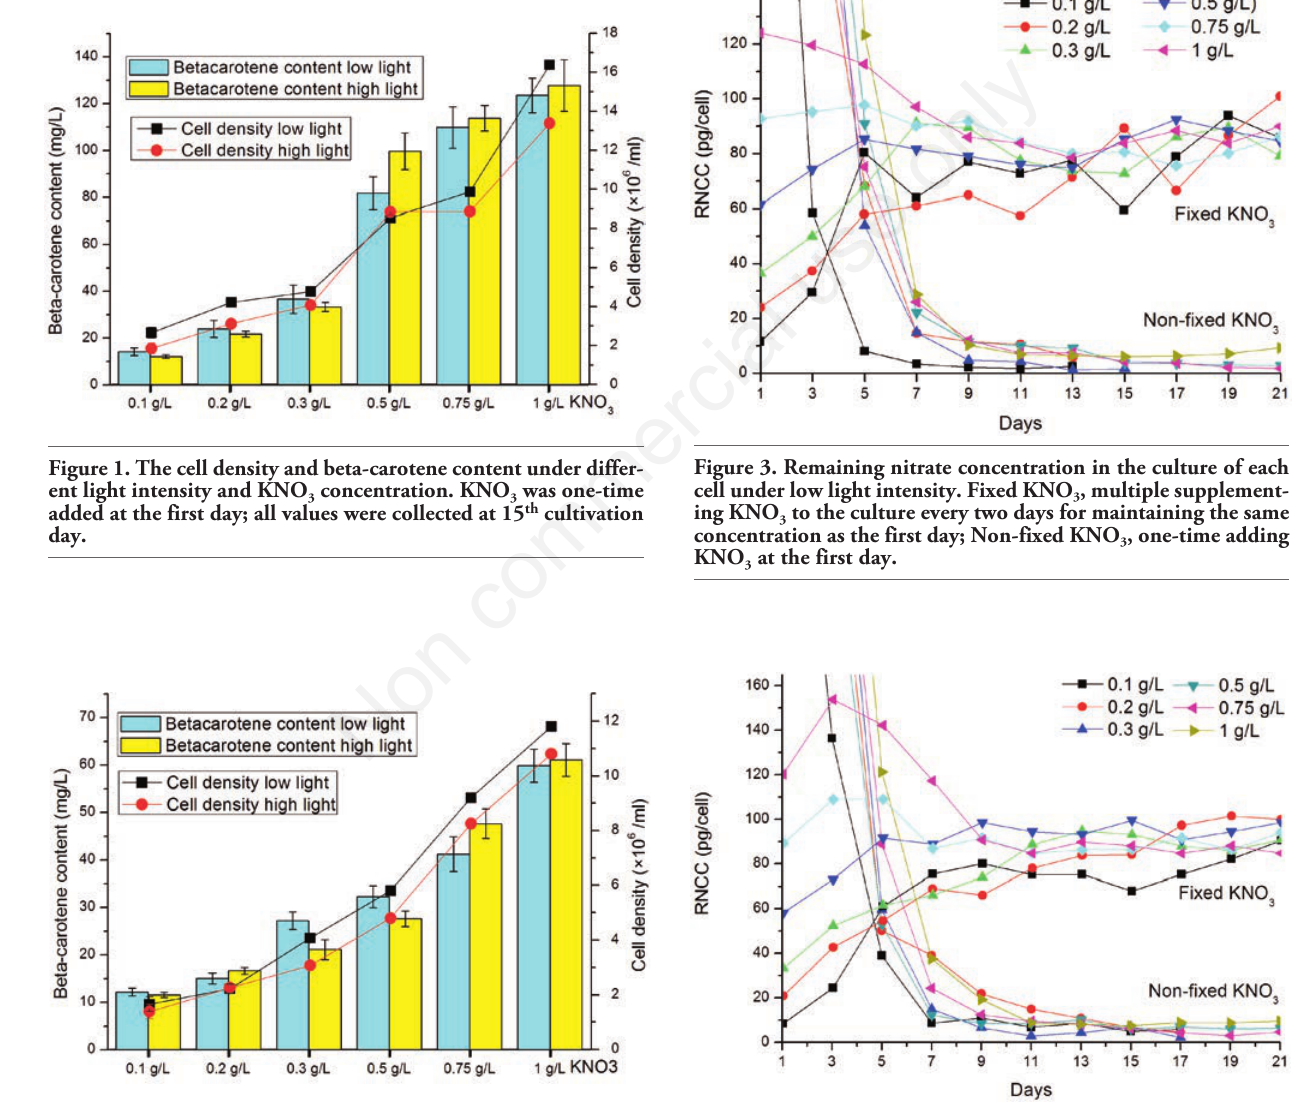
Figure 4. Remaining nitrate concentration in the culture of each cell under high light intensity. Fixed KNO concentration. KNO was multiple 3 3 menting KNO to the culture every two days for maintaining the 3 same concentration as the first day; Non-fixed KNO adding KNO at the first 3